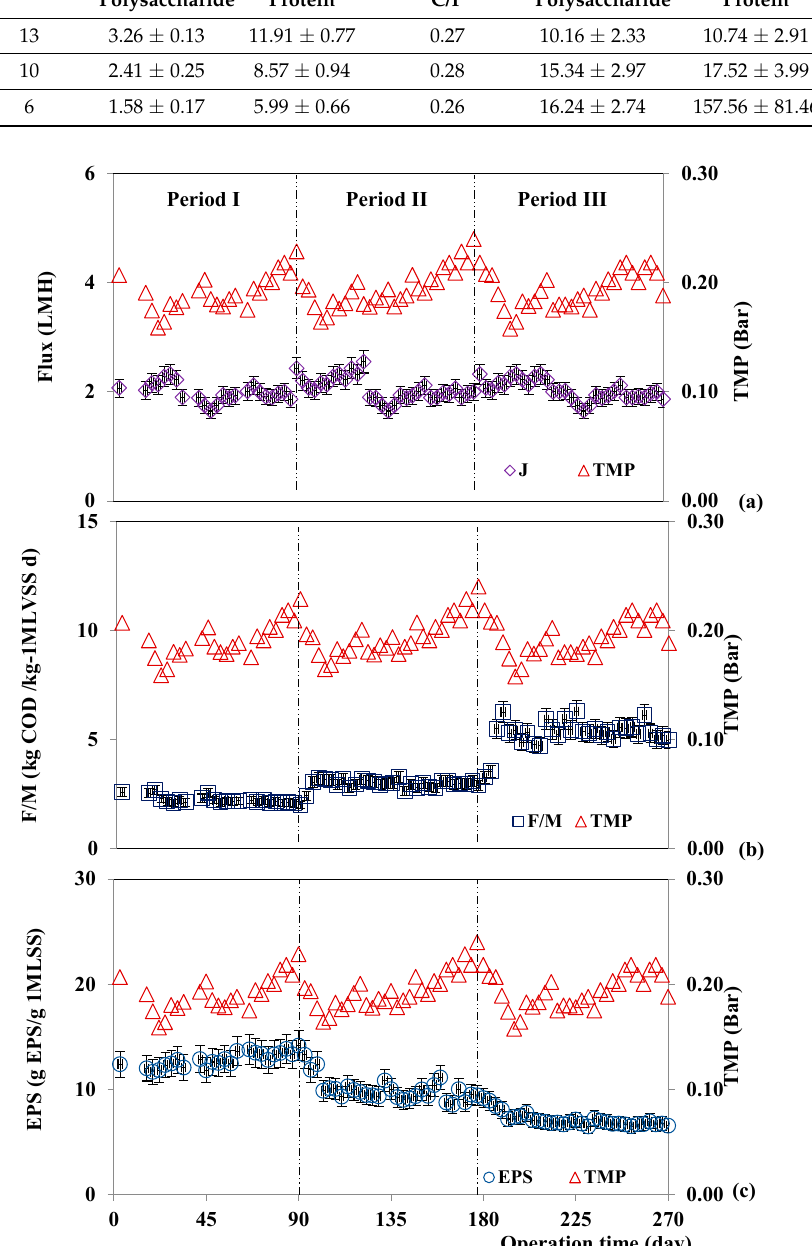
Figure 3. Flux ( a ), F/M ( b ), and EPS ( c ) profiles compared to TMP during operational periods I, II, and III.